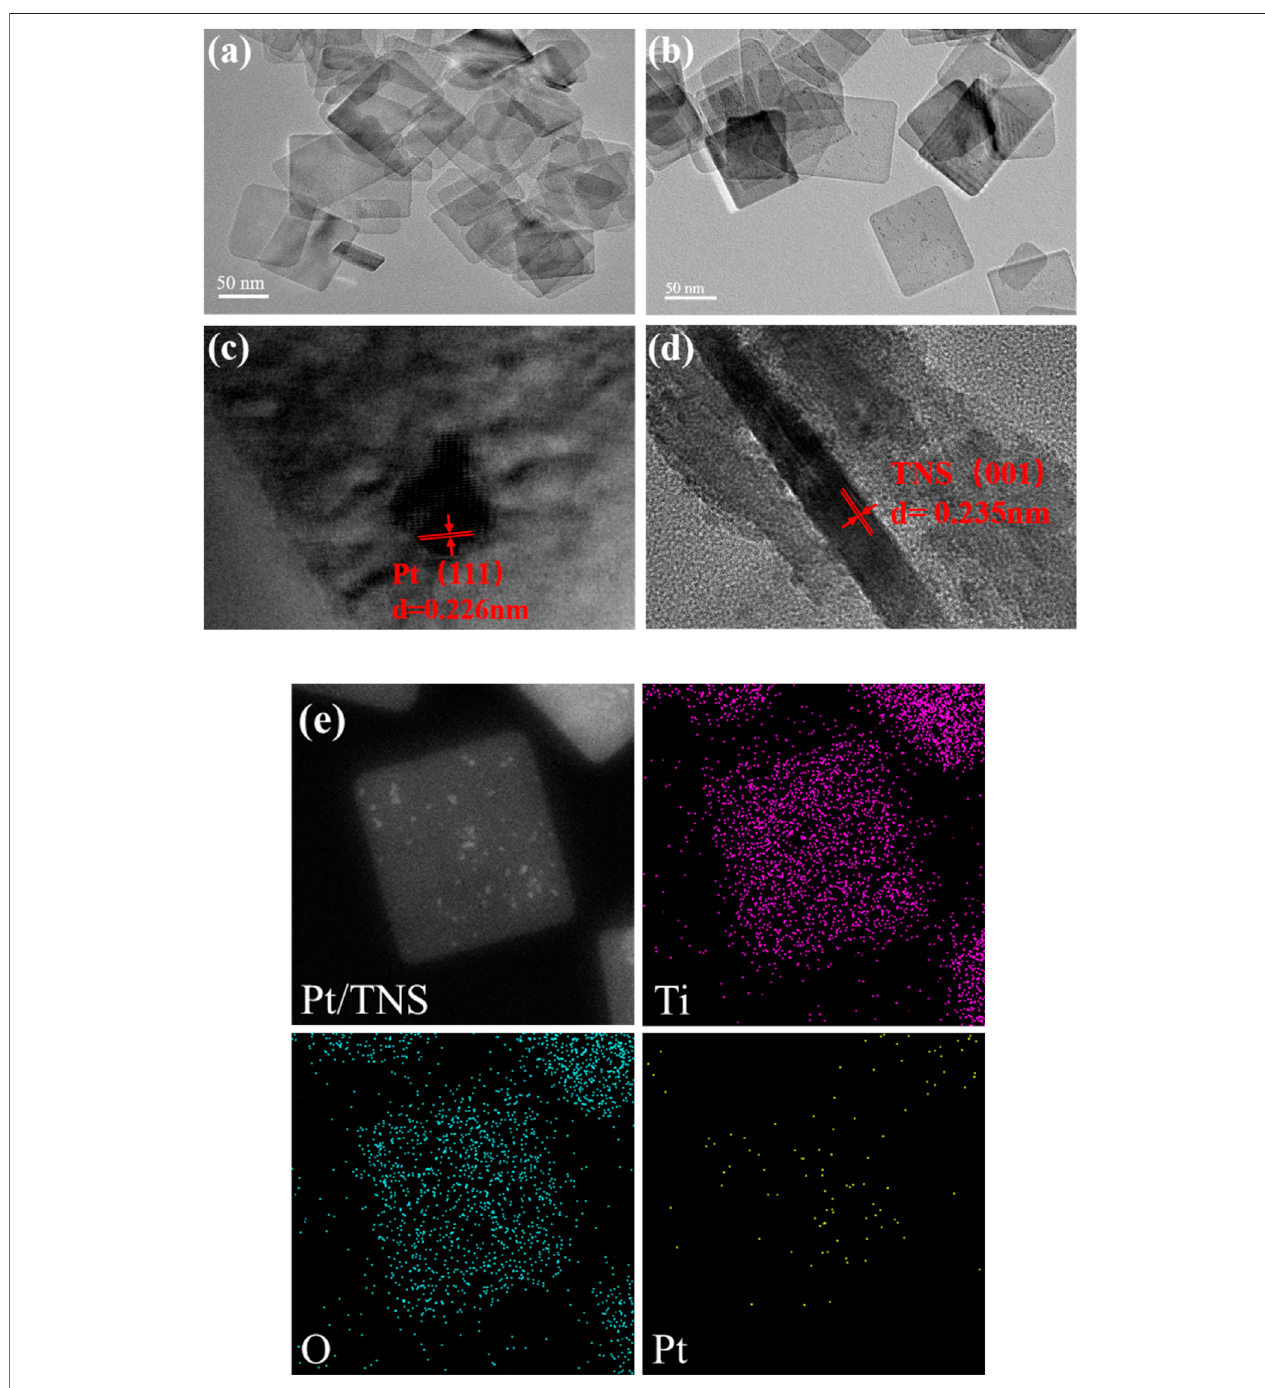
FIGURE 4 | HRTEM images of (A) TNS, (B) Pt/TNS, (C) lattice fringes Pt, (D) lattice fringes TNS, and (E) element distributions of